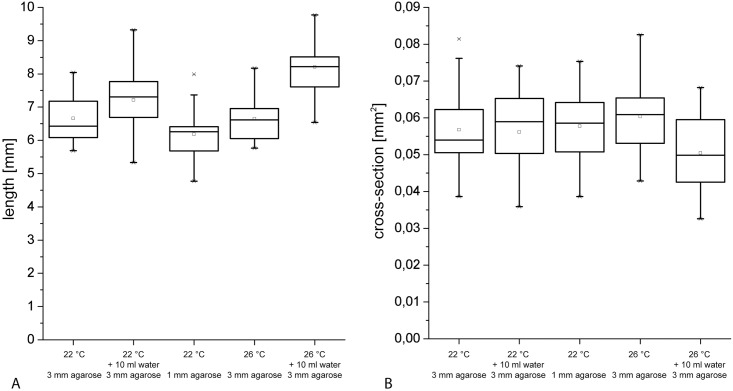
Influence of variations in growth conditions on the geometry of four day old dark grown hypocotyls.A) Length vs. growth conditions. Increased water content in the medium as well as a higher temperature during germination leads to an increase in length. A thinner layer of agarose appears to reduce the nutrient supply sufficiently to slightly decrease length growth. B) Cross-sections vs. growth conditions. Only the combination of an increased temperature during germination and higher water content in the medium induced a slight reduction in cross-section, while the individual alterations and a reduction in the amount of medium had no effect.